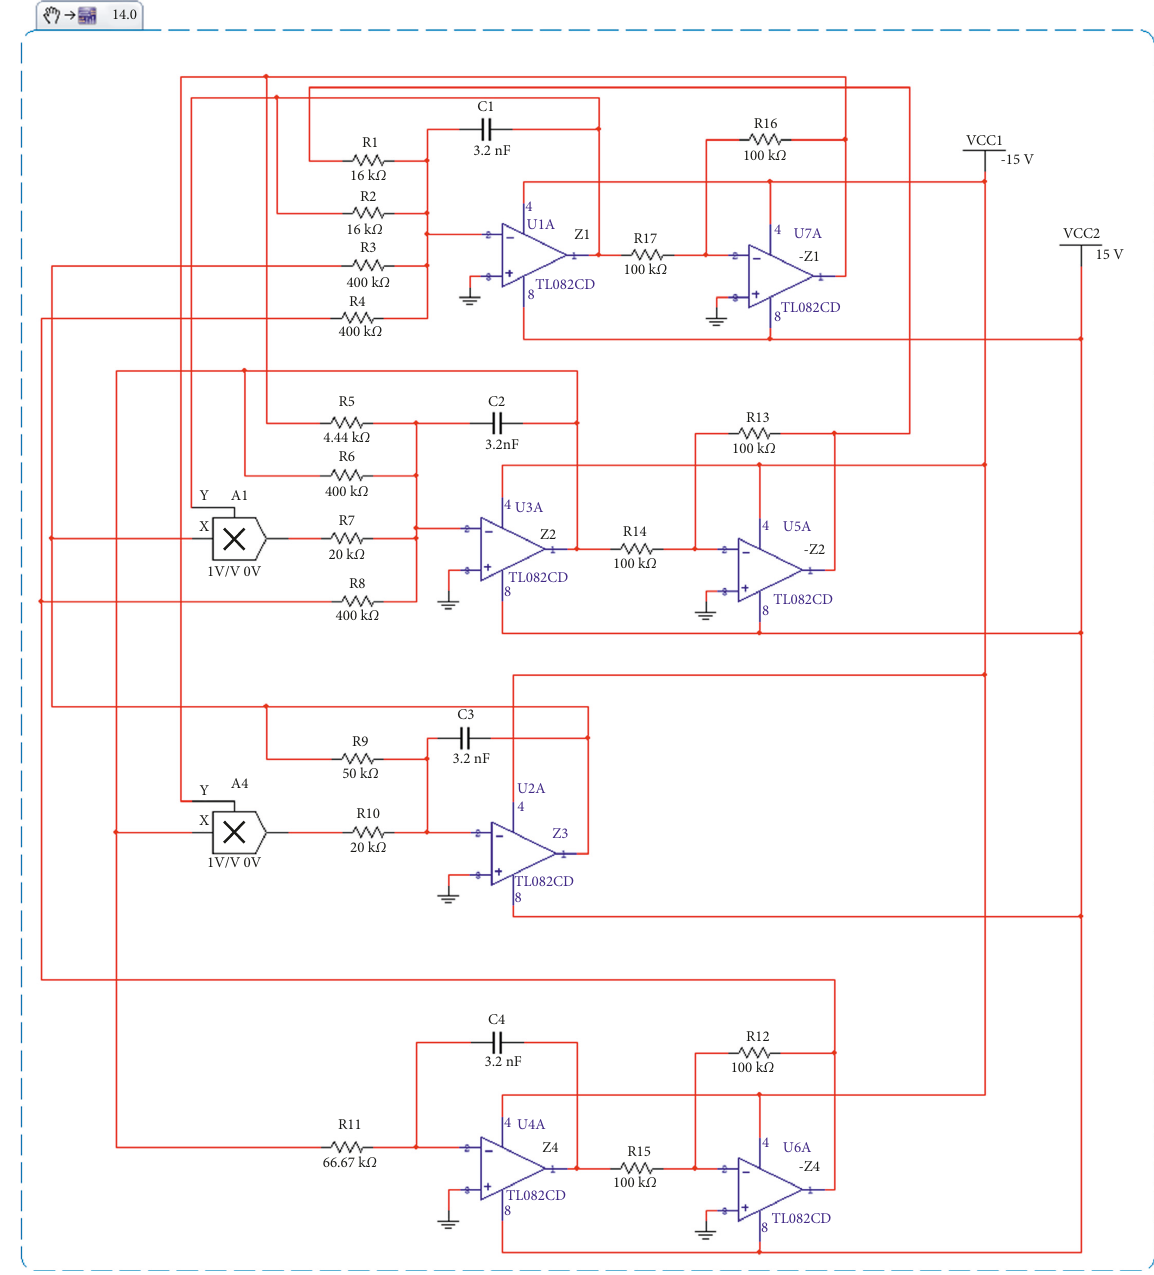
Figure 29: The electronic circuit design for the 4-D hyperchaotic system